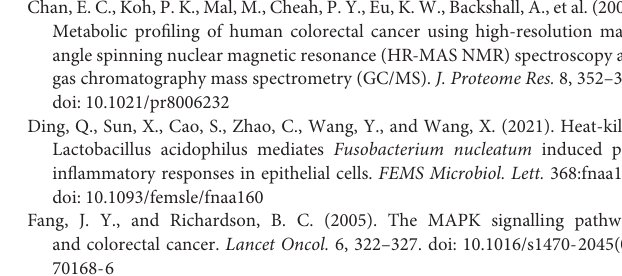
Supplementary Figure 1 | A model diagram of animal experiment design. Supplementary Figure 2 | KEGG pathways and metabolite analysis of fecal samples of CRC patients and mice given Fn gavage. (A) Principal component analysis (PCA) of the OTU and amino acid composition in female vs. male, respectively. (B) Histidine in serum of CRC patients and healthy subjects, ∗∗∗ P < 0.001; (C) correlation analysis heat map of bacteria and KEGG pathways in Con, Fn and Fn + AOM groups; (D) aspartate in tissues of CRC patients based on NMR, # P < 0.05 vs. control, ∗∗ P <